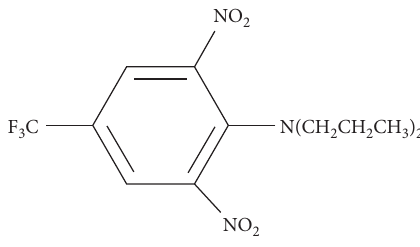
Figure 1: Chemical structures of trifluralin